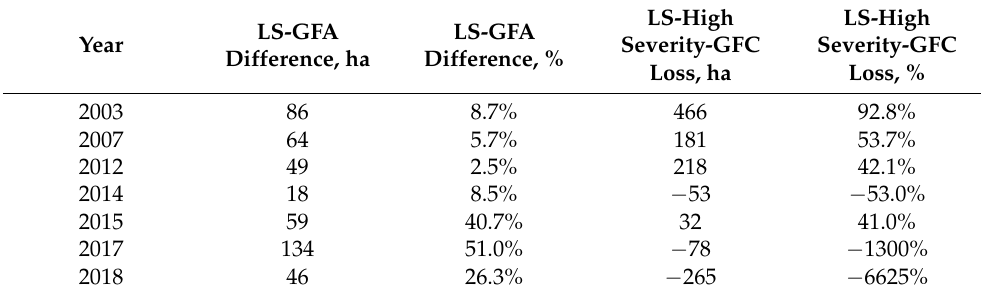
Table 3. Differences in area (ha) and percent between the Landsat (LS) and GFA fire polygons, as well as between GFC forest loss and LS-high severity. Negative values mean the first variable was larger than the